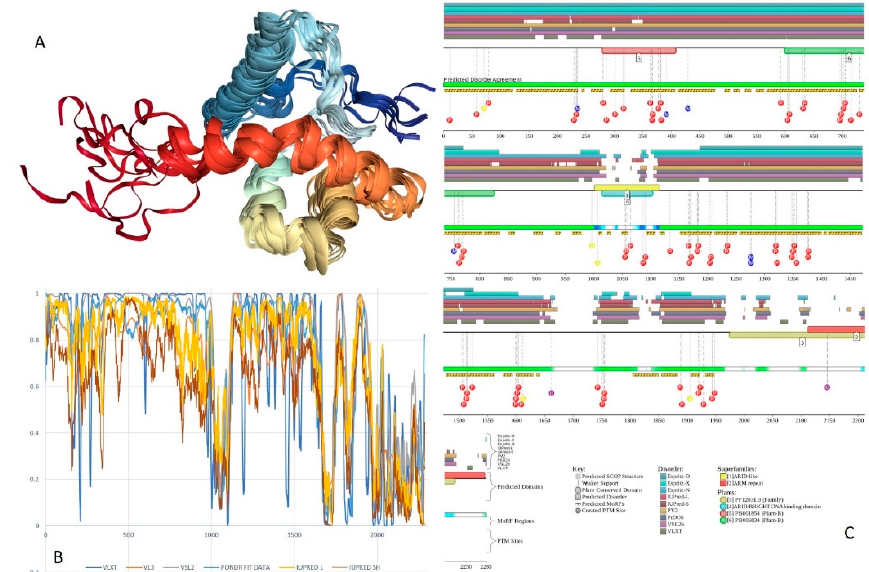
Figure 10. Structural organization of the human BAF250A protein. ( A ) NMR solution structure of the ARID domain (residues 1017–1108; PDB ID: 1RYU). ( B ) Intrinsic disorder profile of human BAF250A generated by six commonly used predictors of intrinsic disorder (PONDR ® VLXT, PONDR ® VL3, PONDR ® VSL2, PONDR ® FIT, IUPred_short, and IUPred_long) ( C ) D 2 P 2 functional disorder profile of the human BAF250A protein (UniProt ID: O14497).